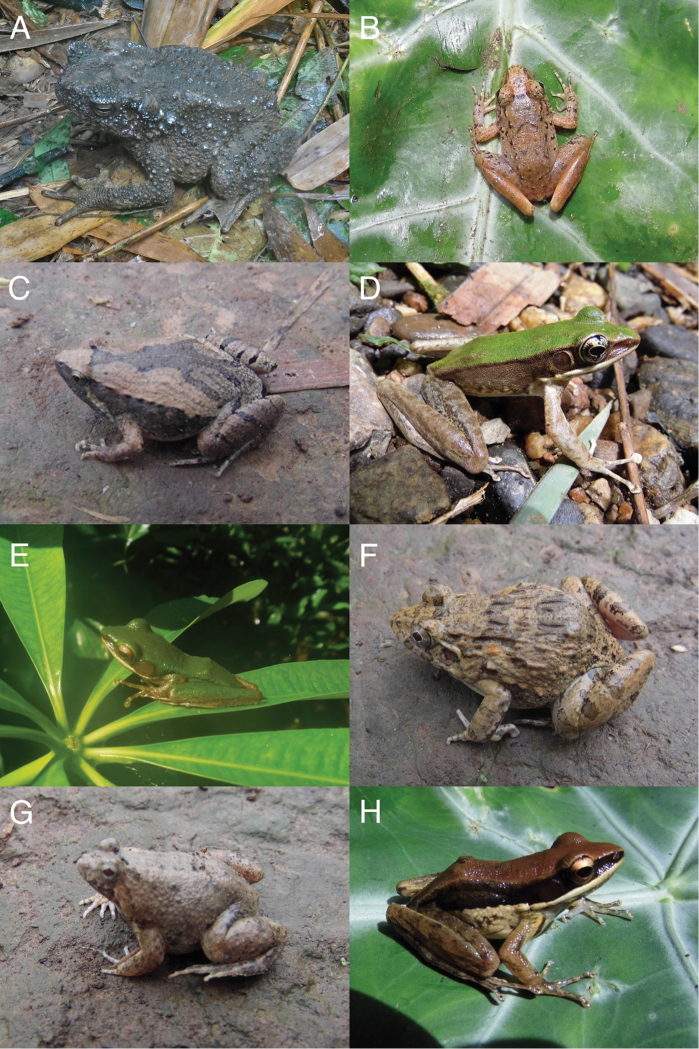
Selected amphibians found during this study’s expedition. A
Phrynoidis
aspera (USNM 586871) B
Limnonectes
doriae (USNM 586911) C
Microhyla
fissipes (USNM 586949) D
Odorrana
hosii (USNM 586980) E
Chalcorana
eschatia (USNM 586971) F
Fejervarya sp. (USNM 586881) G
Occidozyga
martensii (USNM 586930) H
Sylvirana
malayana (USNM 586970). Photos by Myint Kyaw Thura and Daniel G. Mulcahy.